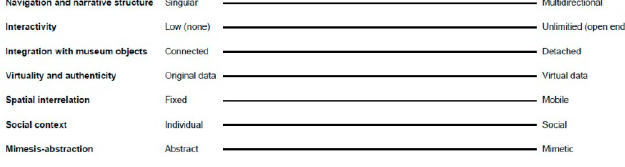
Figure 2. Conceptual framework for audio-visual museum media.